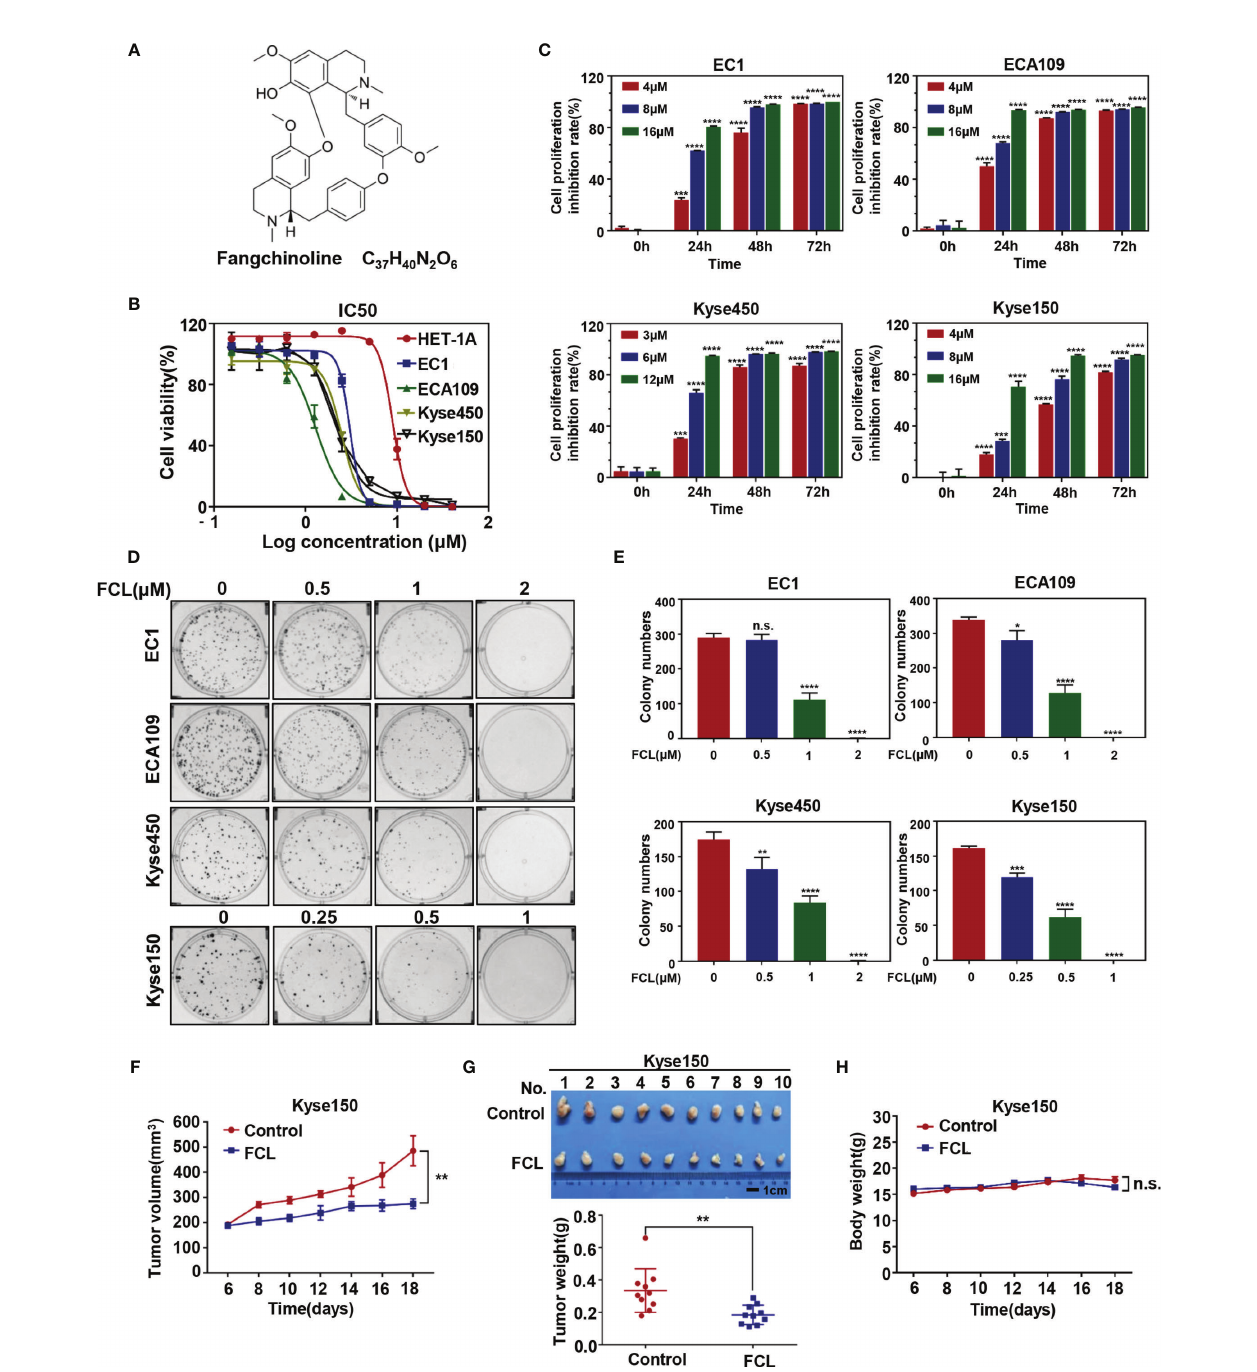
FIGURE 1 | Ef fi cacy of Fangchinoline on ESCC in vitro and in vivo . (A) Chemical structure of FCL. (B) Human esophageal epithelial cell line HET-1A and ESCC cell lines EC1, ECA109, Kyse450, Kyse150 were treated with indicated concentrations of FCL for 72 hours, and cell viability was determined by ATPlite assay. Representative inhibitory curves for each cell line are shown. (C) ATPlite assay was used to determine the cell growth of different ESCC cell lines at the indicated concentrations of FCL for 0, 24, 48 and 72 hours. (D) Representative images of three independent experiments are shown for the inhibition of colony formation by FCL. (E) Graph of the relative number of colonies formed. (F) Nude mice were subcutaneously transplanted Kyse150 cells and treated with FCL as indicated in Materials and Methods. Tumor size was determined with caliper every other day, and the volume was calculated to construct a growth curve. (G) Mice were sacri fi ced, and tumor tissues were harvested and photographed. The tumor weight was measured with an electronic scale on the sacri fi ced day. (H) Mouse body weight was recorded every other day during the whole experiment. *denotes P < 0.05, **denotes P < 0.01, ***denotes P < 0.001, ****denotes P < 0.0001, n.s. denotes not signi fi